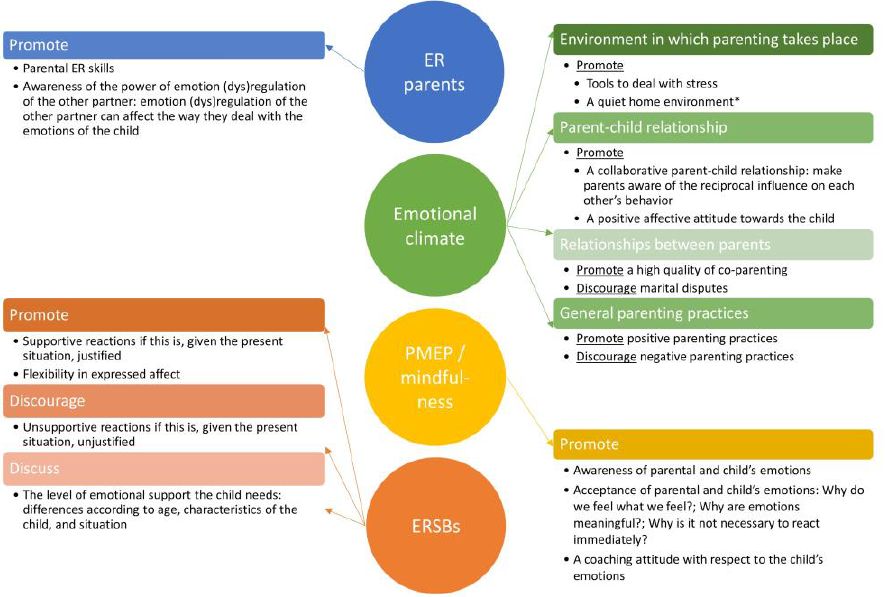
Figure 3. Overview of the recommendations for interventions. * Evidence for this statement is not conclusive.